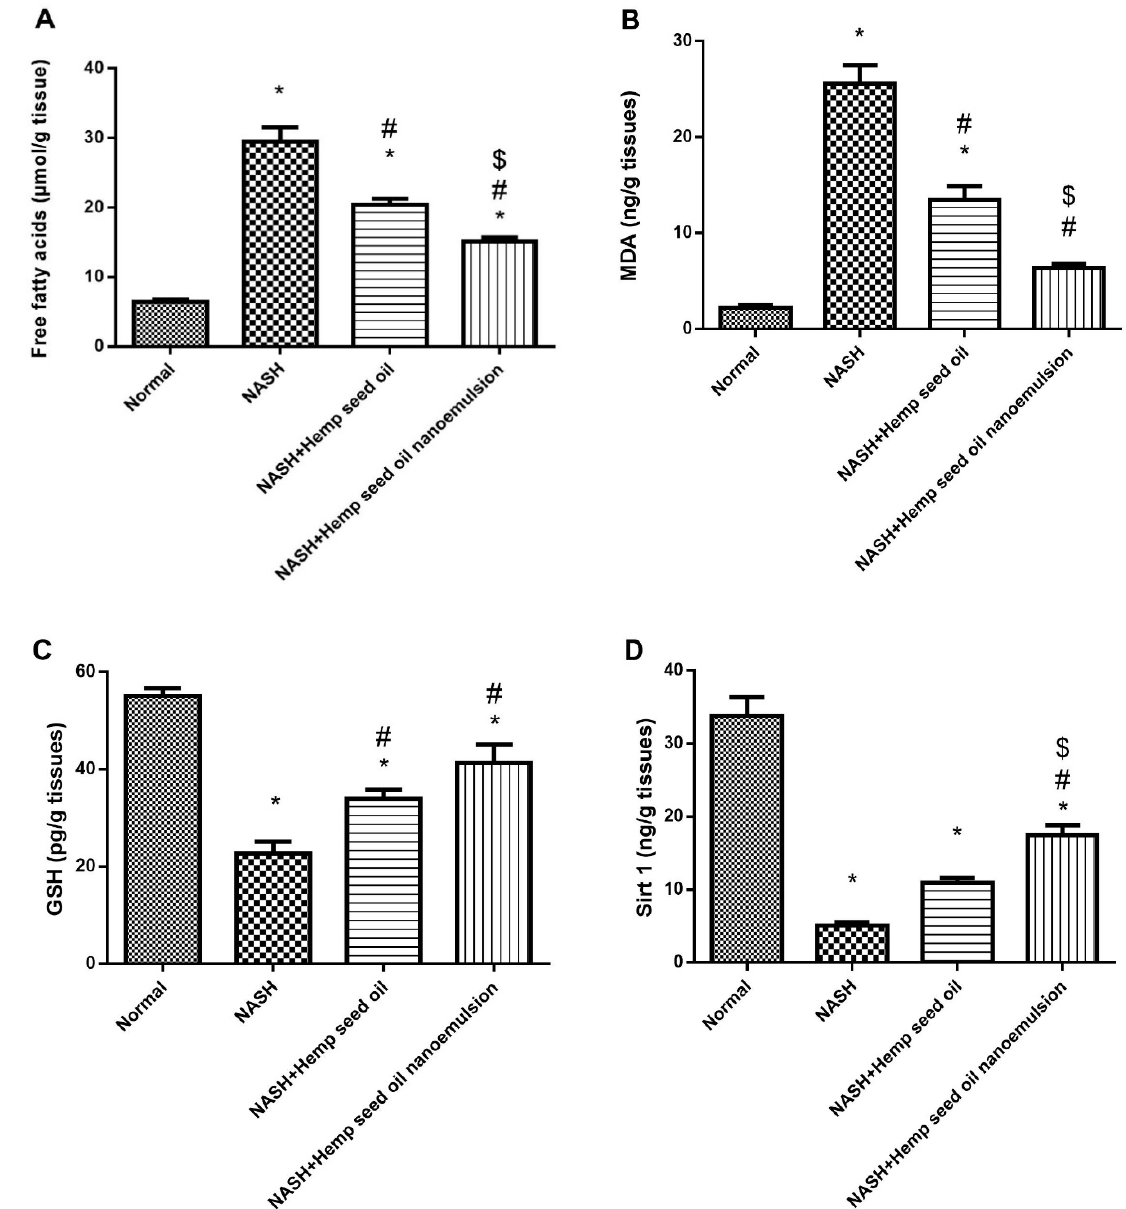
Figure 8. Effect of hemp seed oil and NEF4 on the hepatic level of free fatty acids and oxidation parameters. ( A ) Free fatty acid, ( B ) MDA, ( C ) GSH, and ( D ) Sirt1 levels of the experimental groups. Data were processed for statistical analysis using one-way ANOVA and then Bonferroni’s test for pair-wise comparison at p < 0.05. Data are expressed as means ± SD. * Different from normal group, # Different from the NASH group. $ Different from NASH + hemp seed oil group at p < 0.05.